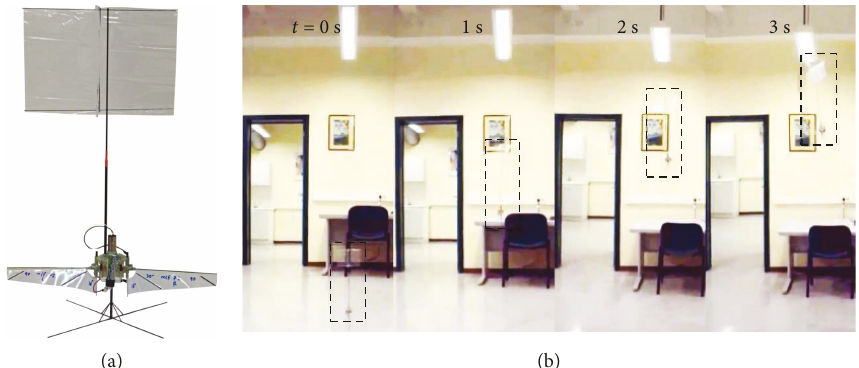
Figure 13: Take-o ff demonstration with sail-like damper for passive stability: photo of the prototype vehicle used in the test (a) and take-o ff sequence (b). The full video recording is available online: https://youtu.be/oaFR815dtIo [20].